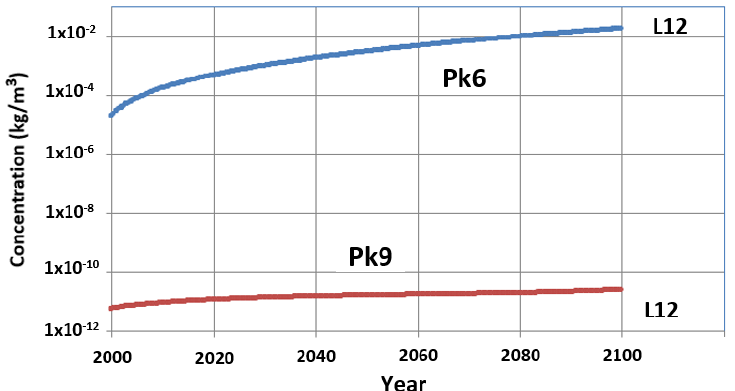
Figure 13. Concentrations variation at wells Pk6 and Pk9 under RCP scenario 2.6.